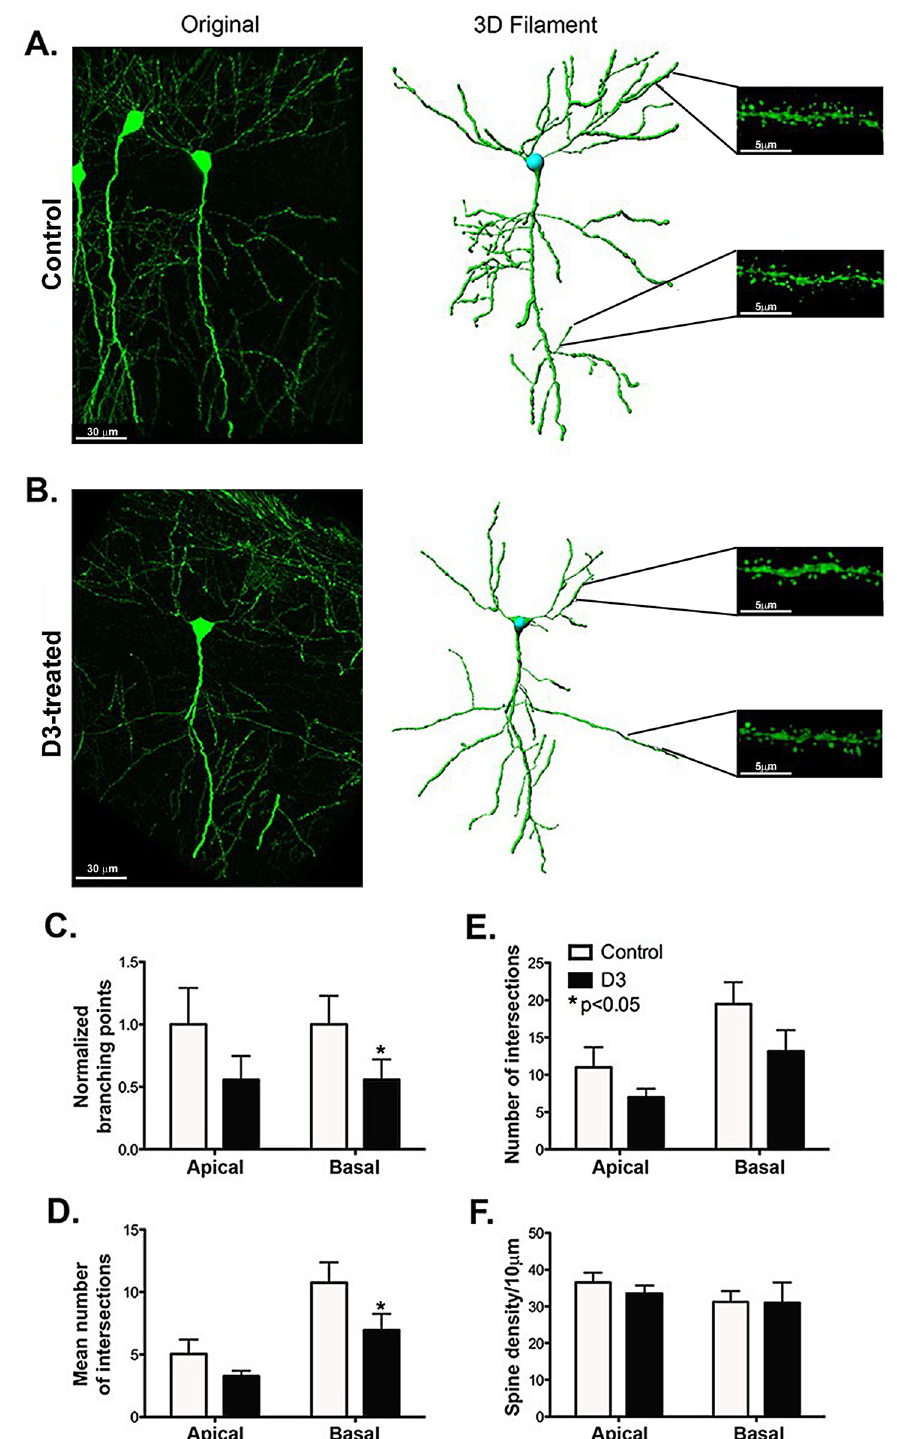
Fig 4. D3 reduces dendritic arborization in the basal CA1 region. (A) Representative confocal image, 3D filament, and magnified segments from apical and basal CA1 tertiary dendrites of an independent neuron from a control mouse. (B) Representative confocal image, 3D filament and magnified segments from apical and basal CA1 tertiary dendrites of an independent neuron from a 2-week D3-treated mouse. (C) Quantification of branching in the apical and basal region shows a decrease in branching points, significant in the basal dendrites of mice treated with D3 (p < 0.05).